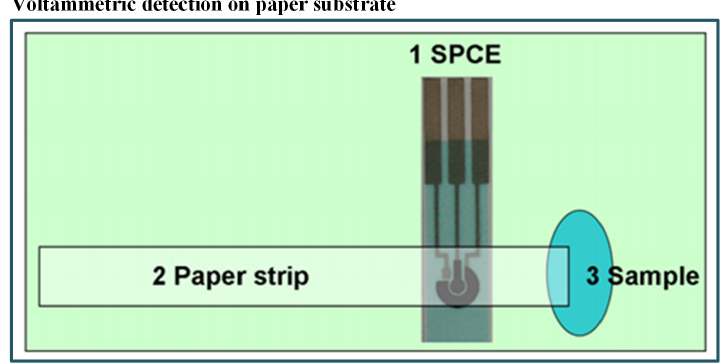
Figure 3. Schematic of paper-based method including integrated commercial screen-printed carbon electrodes with filter paper strips for detection of Pb +2 and Cd +2 [111].